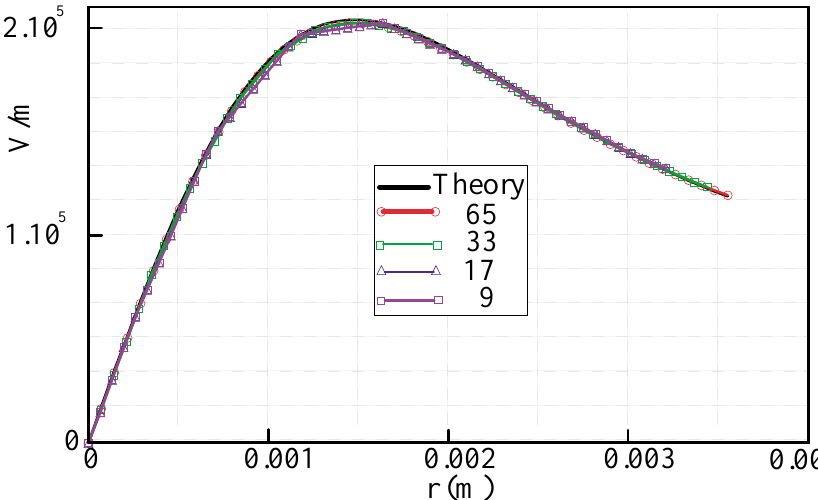
FIG. 4. (Color) Theoretical field and computed fields for different resolutions of the finest grid ( 65 3 , 33 3 , 17 3 , 9 3 ).